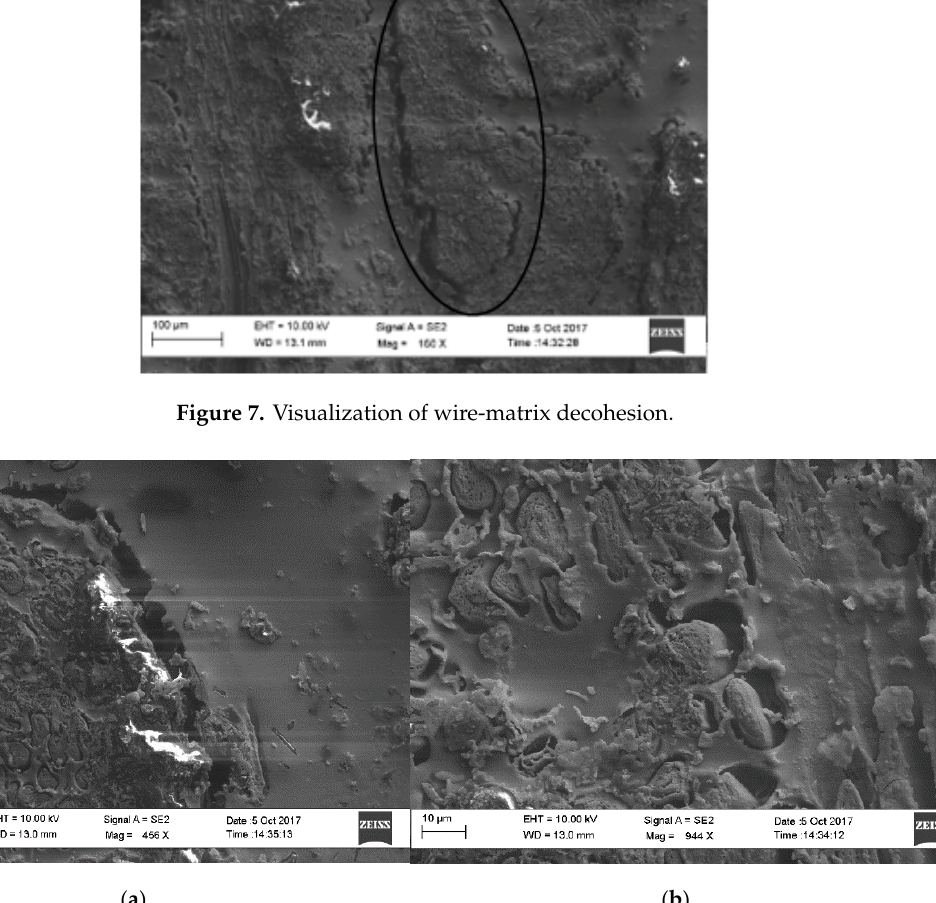
Figure 8. Visualization of decohesion between fibre/matrix. ( a ) global view, ( b ) detailed view.